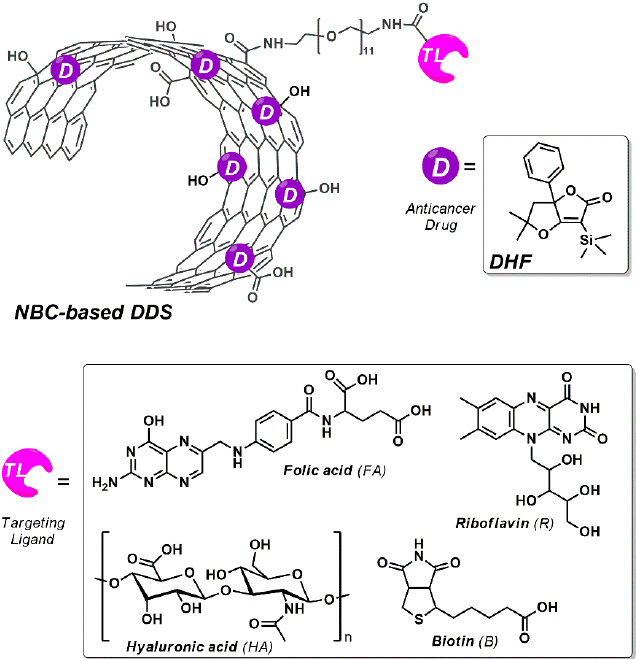
Figure 1. NBC-based DDS for targeted cancer therapy.